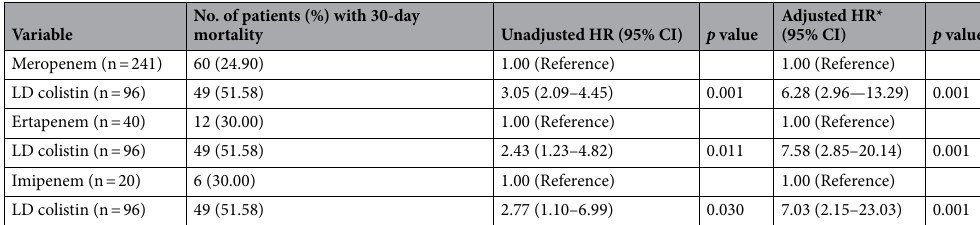
Table 3. Cox regression analysis of 30-day mortality of patients treated with LD colistin and carbapenems (meropenem, ertapenem, imipenem) for the infection caused by ESBL-producing E. coli and K. pneumoniae. * Adjusted for gender, ICU admission, use mechanical ventilation, duration of hospitalization, appropriate antibiotic treatment, Charlson comorbidity score, cerebrovascular disease, diabetes mellitus, infection type and nephrotoxicity. CI, confidence interval; HR hazard ratio.